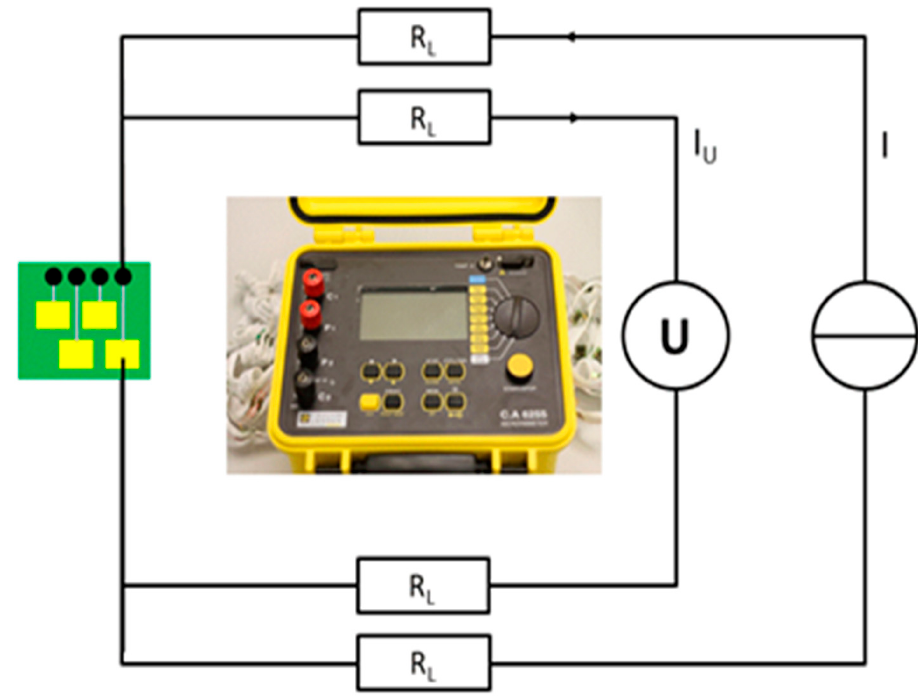
Figure 4. Measuring setup to determine the contact resistances using four-wire measuring technology.